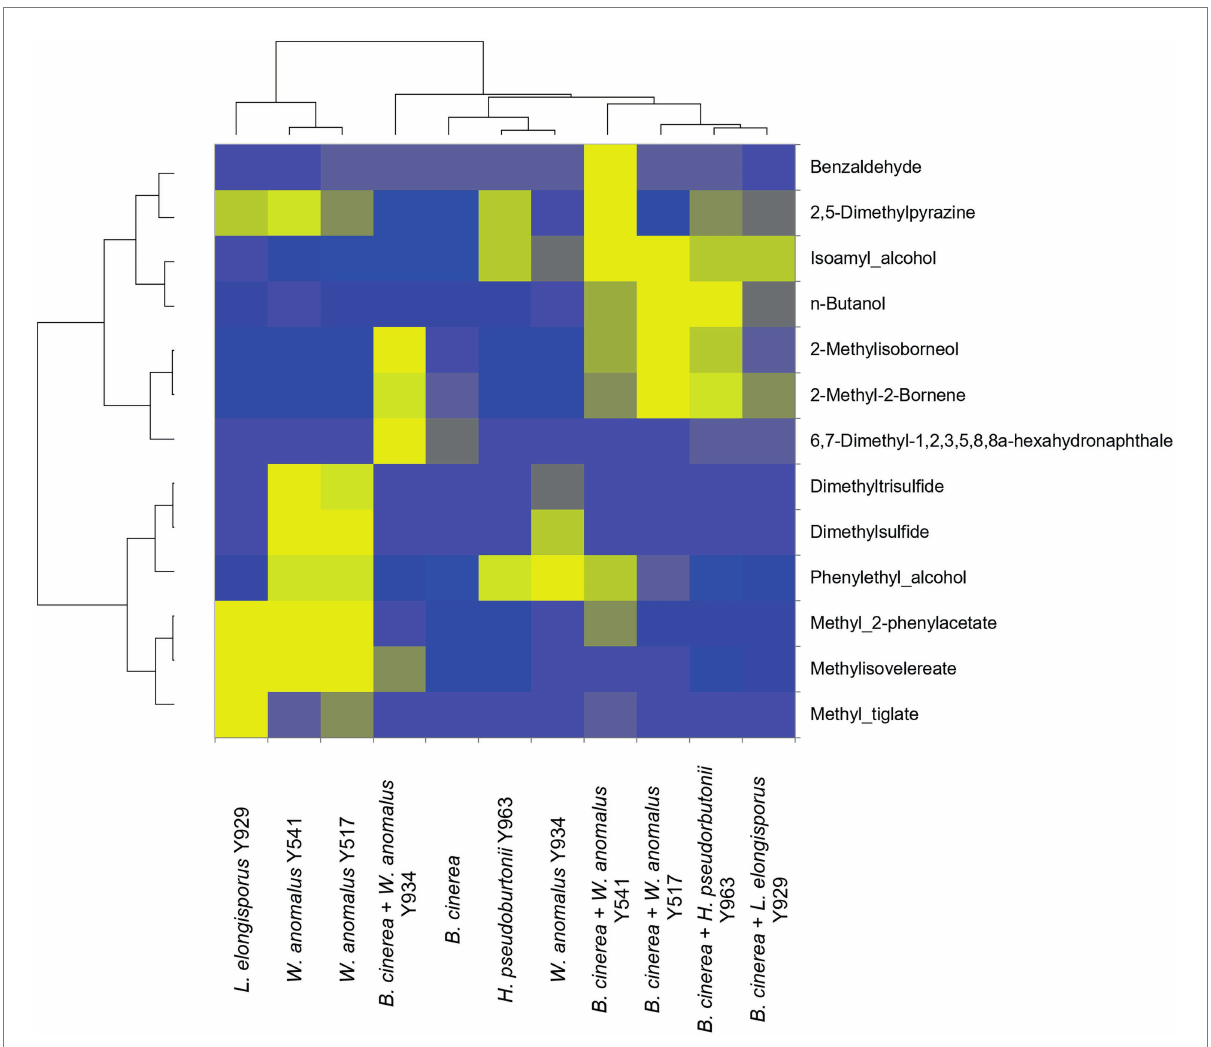
FIGURE 4 Relative fold changes coloured from blue (lowest) to yellow (highest) of volatile organic compounds produced by Botrytis cinerea (control) and yeast strains co-cultured with various yeasts strains. Compounds were identified using Anisole d8 (Std), comparison with mass spectra from MS NIST05 spectral